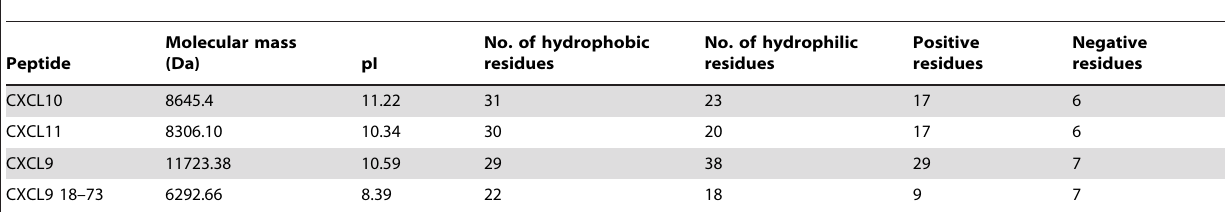
Table 2. Biochemical properties of CXCL10, CXCL11 and CXCL9 (intact and SpeB cleaved).